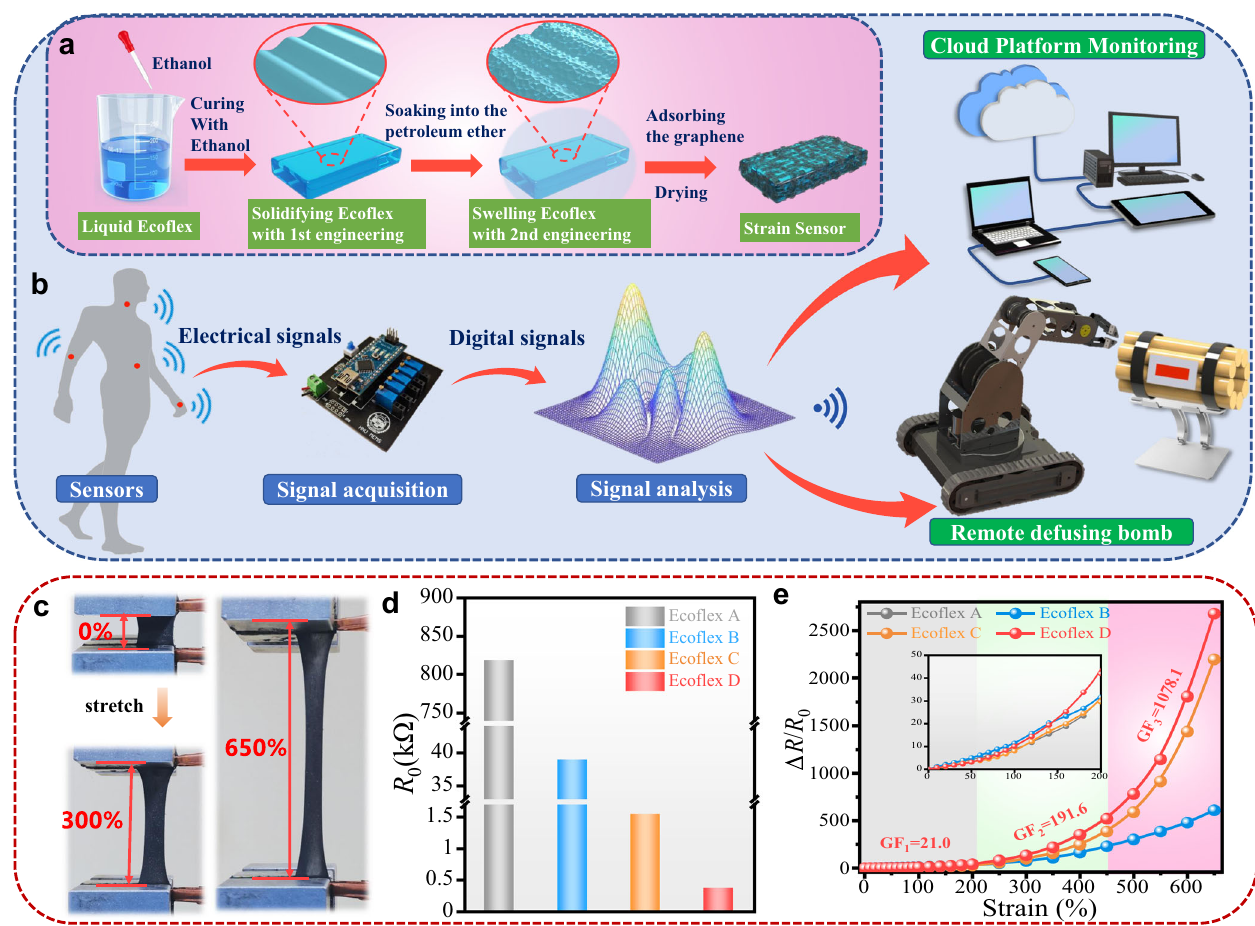
Fig. 1 Fabrication processes, performance and application scenario of the graphene/Eco fl ex strain sensor. a Schematic illustrations of fabrication processes for the graphene/wrinkled Eco fl ex strain sensors; b Diagrams of the fl exible sensors that can detect and capture the physiological signals from human body, signal acquisition unit, signal analysis unit, cloud platform monitoring and remote defusing bomb; c Photographs of the graphene/Eco fl ex strain sensor under the tension strain of 0%, 300 and 650%; d The initial resistance of four types of graphene/Eco fl ex strain sensor; e the relative resistance changes ( Δ R / R 0 ) versus strain for four types of graphene/Eco fl ex strain